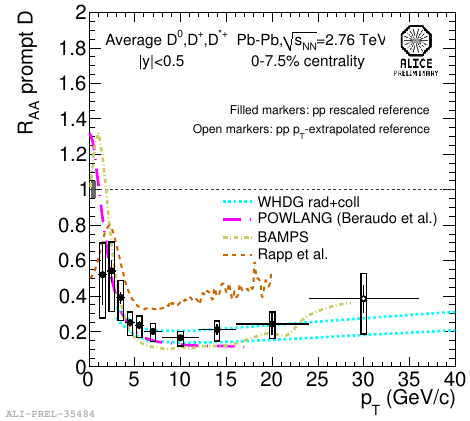
Figure 3. Average D 0 , D + and D ∗ + nuclear modification factor R AA vs p T for central Pb-Pb collisions, compared with